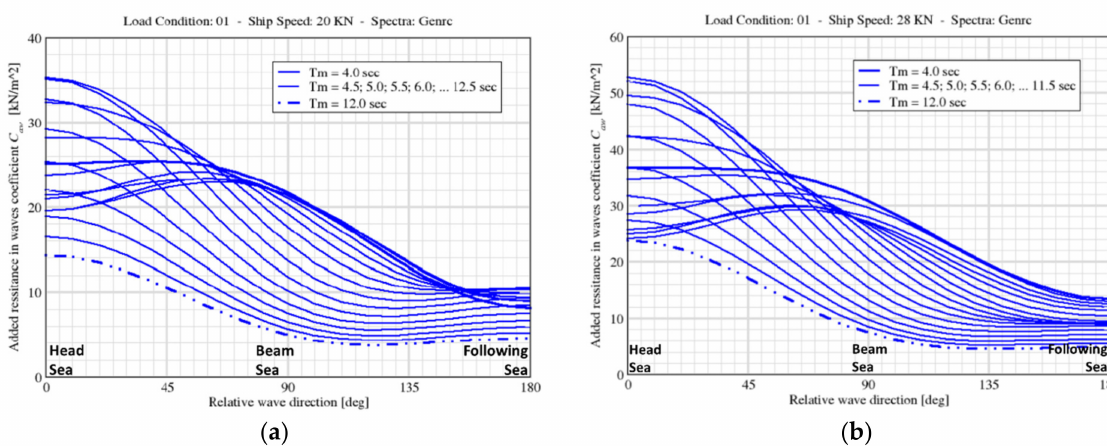
Figure 5. Added resistance in waves coefficient C aw computed, according to Equation (8), with “generic” unitary wave spectra, for different values of the average Wave Period T m and of the Average Wave Direction D m (waves from). The used ARO functions are those computed by PDSTRIP for the RoPax ship of Table 1, at the speed of ( a ) 20 knots and ( b ) 28